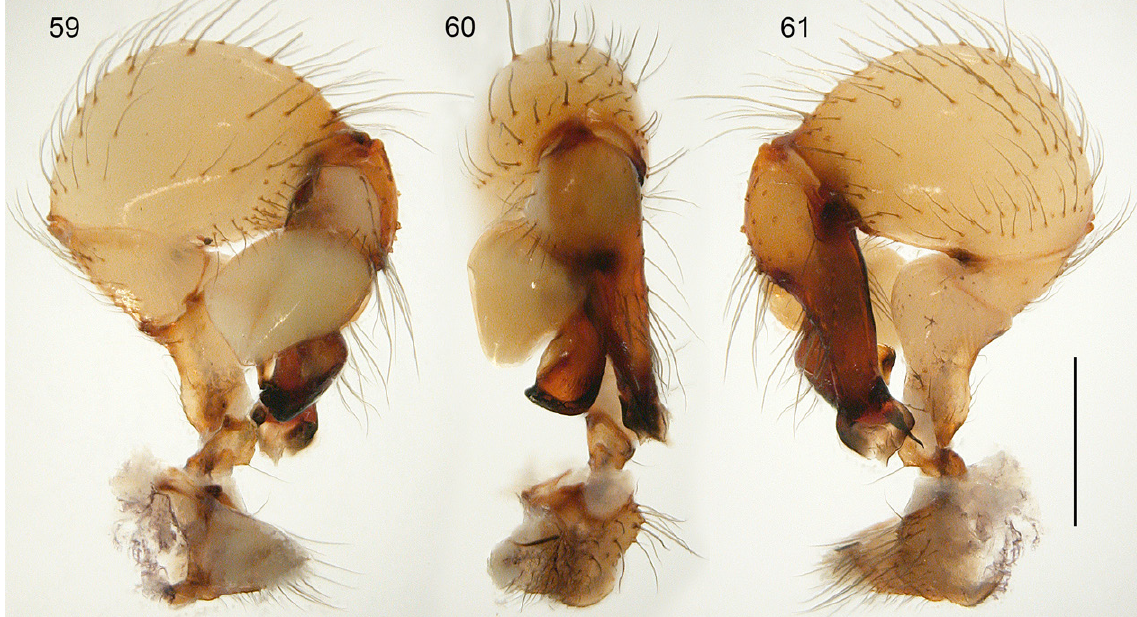
Figs 59–61. Holocnemus reini (C. Koch, 1873) comb. nov.; male from Morocco, near Tilamizene (ZFMK Ar 22319); left palp, prolateral, dorsal, and retrolateral views. Scale bar = 0.5